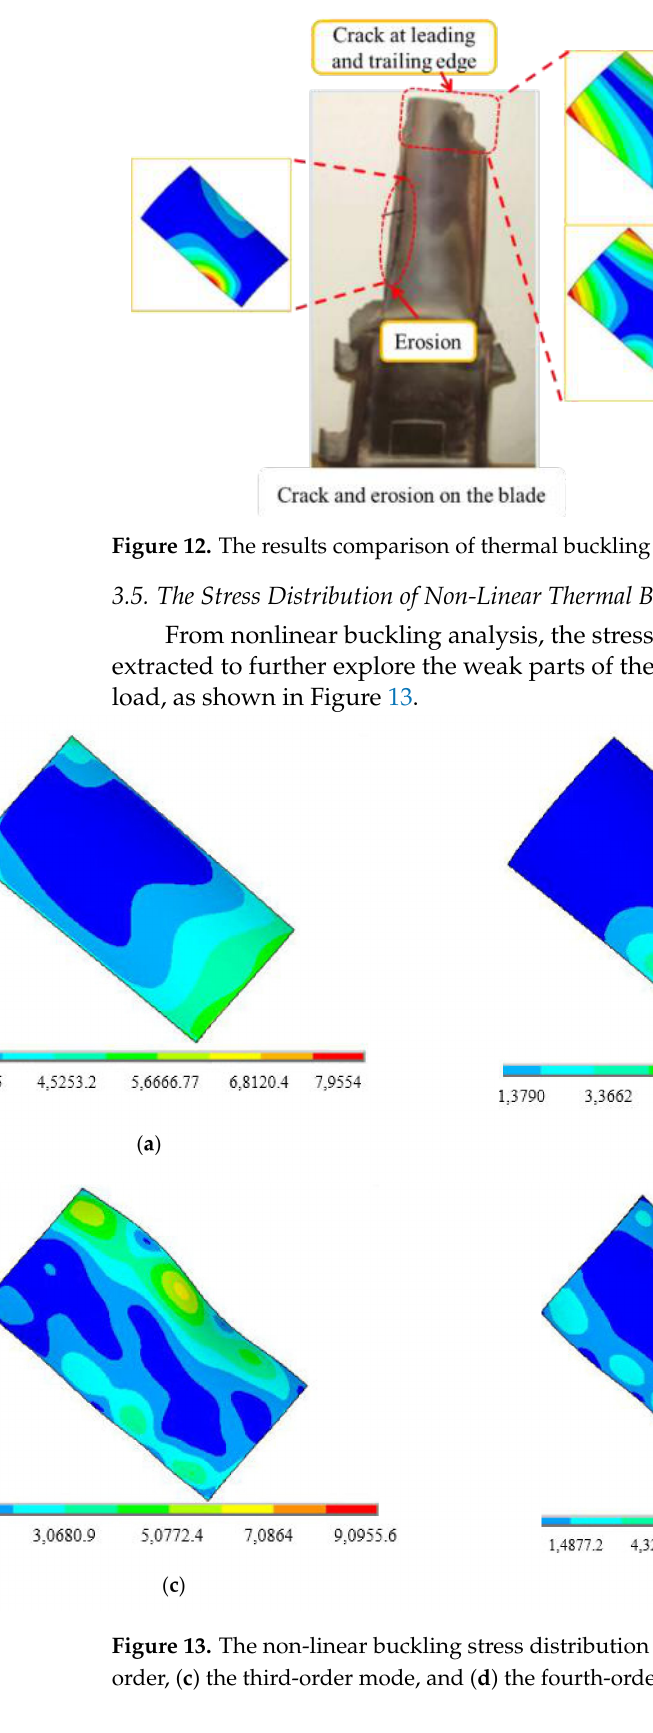
order, ( c ) the third-order mode, and ( d ) the fourth-order